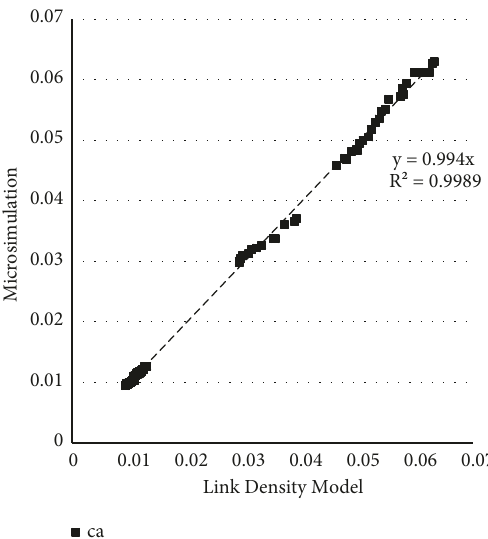
Figure 13: Link Flow Dispersion: Microsimulation vs Density- Based Model.